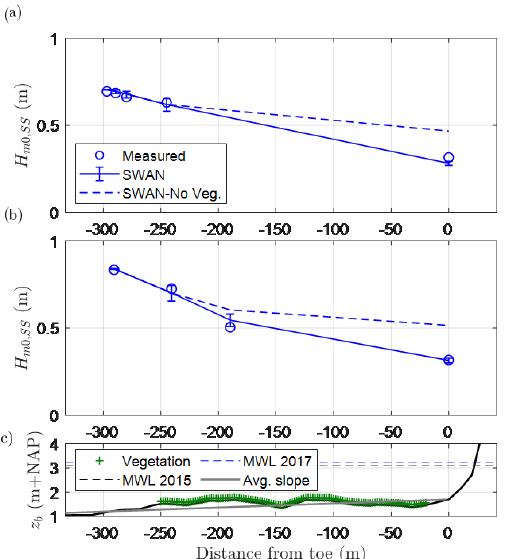
Figure 7. Comparison of measured and modelled relative magni- Figure 6. Comparison of measured and modelled significant wave tude of the IG waves ( ˜ H IG ) at the peaks of the (a) January 2015 and heights in the SS bands ( H m ) at the peaks of the (a) Jan- 0 , SS (b) January 2017 storms at Uithuizerwad (see Fig. 5 for gauge loca- uary 2015 and (b) January 2017 storms at Uithuizerwad (see Fig. 5 tions). Error bars represent the uncertainty in the estimates based on for gauge locations). Error bars represent the uncertainty in the es- the standard deviation of Eq. (12). Panel (c) shows the bed level and timates based on the standard deviation of Eq. (4). Panel (c) shows vegetated cover. MWL: mean water level (at the peak of the storm). the bed level and vegetated cover. MWL: mean water level (at the peak of the storm).